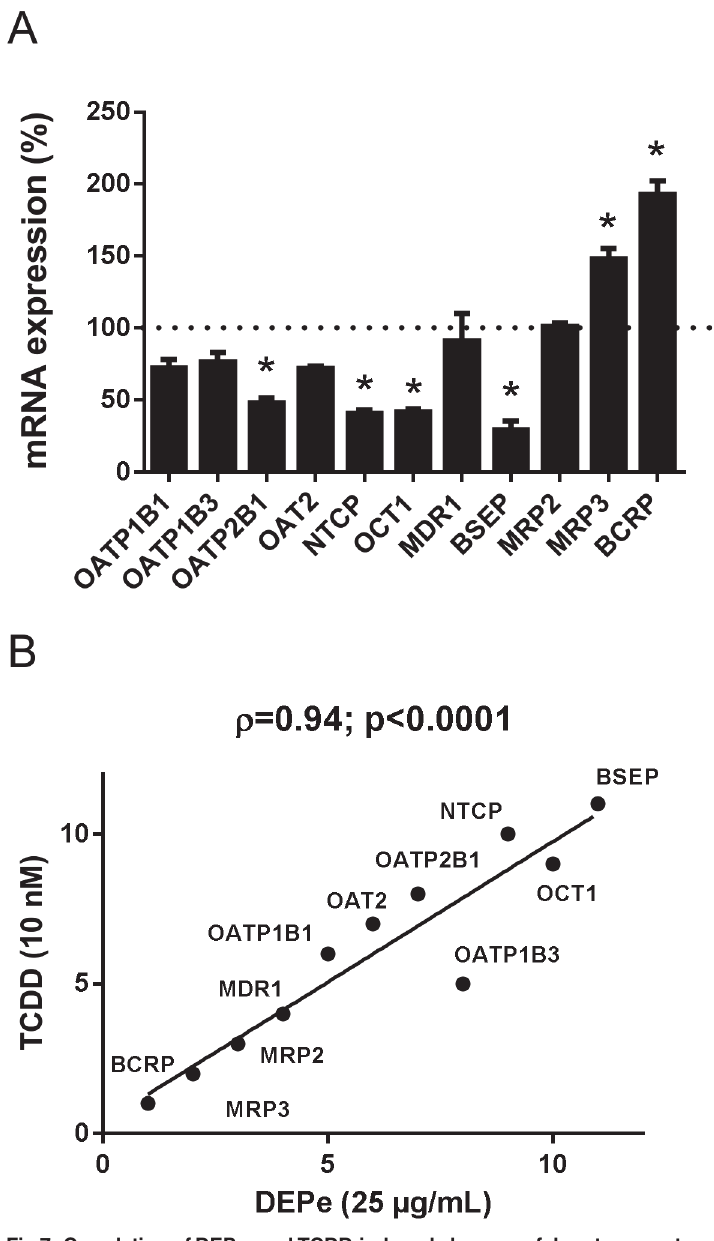
Fig 7. Correlation of DEPe- and TCDD-induced changes of drug transporter mRNA expression. (A) HepaRG cells were either untreated or exposed to 10 nM TCDD for 48 h. Drug transporter mRNA expression was evaluated by RT-qPCR. Data are expressed as % of transporter expression found in control untreated cells, arbitrarily set at the value of 100% and indicated by a dotted line; they are the means ± SEM of three independent assays. * , p < 0.05 when compared to control cells (ANOVA followed by a Dunnett ’ s post-hoc test). (B) Drug transporters were ranked according to regulation of their mRNA expression in response to a 48-h treatment by 25 μ g/mL DEPe or 10 nM TCDD. For this purpose, transporters were ranked for each treatment from the most induced transporter to the most repressed, from data from Fig. 5B and Fig. 7A. Correlation was analysed using the Spearman's rank correlation method. Spearman's rank coefficients ( ρ ) and p values are provided on the top of the correlation